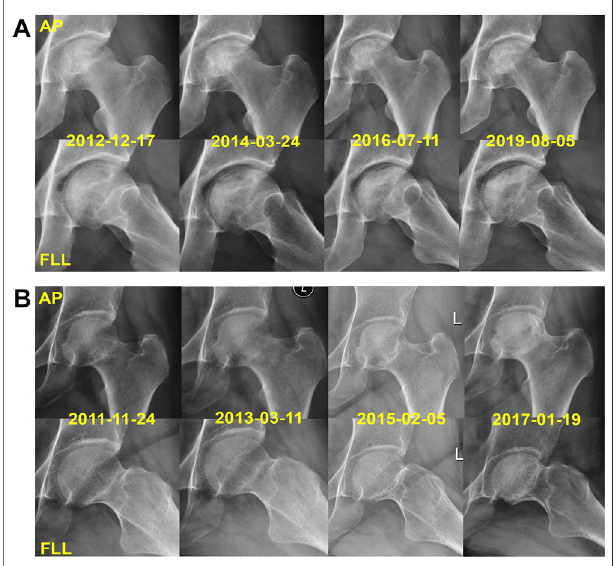
FIGURE 8 | Two representative cases with JIC type C1 lesions. (A) X-rays of the left hip joint of a 42-year-old male with AONFH had a pretreatment LPA of 65 ° and APA of 67 ° ; there was no collapse of the femoral head in the follow-up of 7.04 years. (B) X-rays of the left hip joint of a